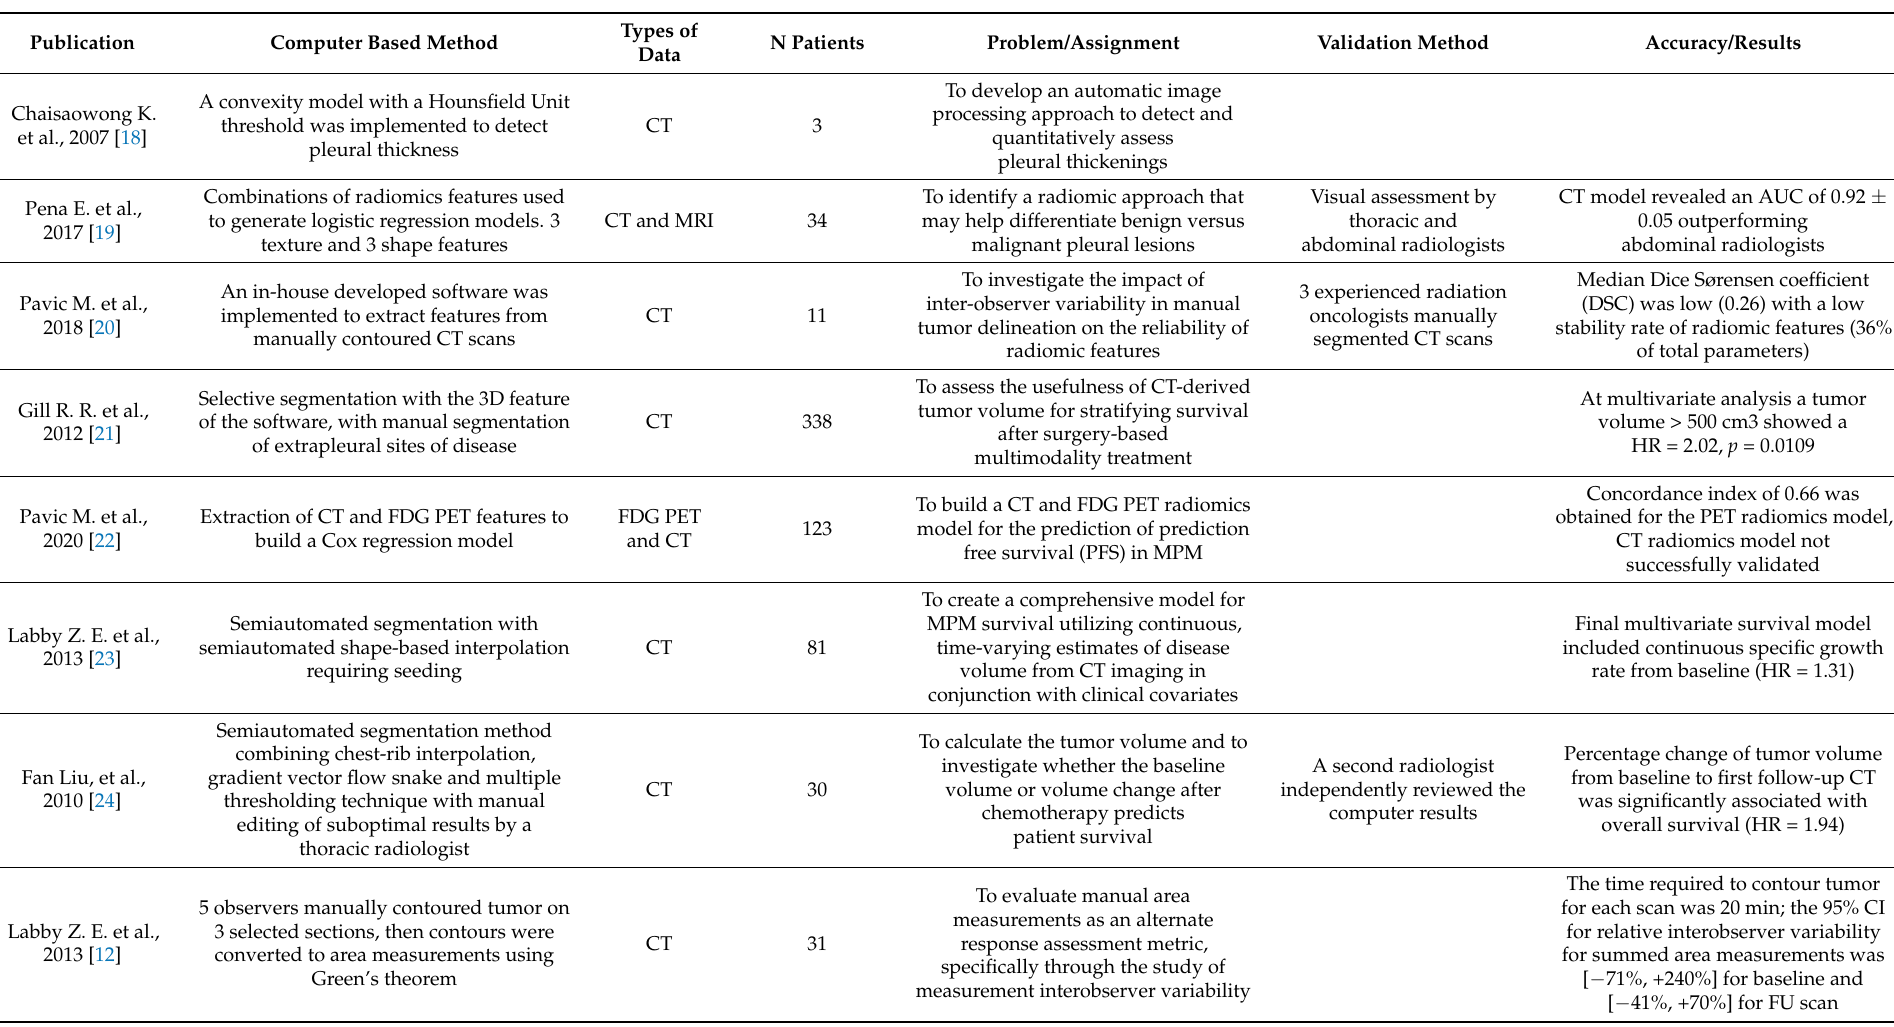
Table 1. Summary of studies on computer-based methods included in the